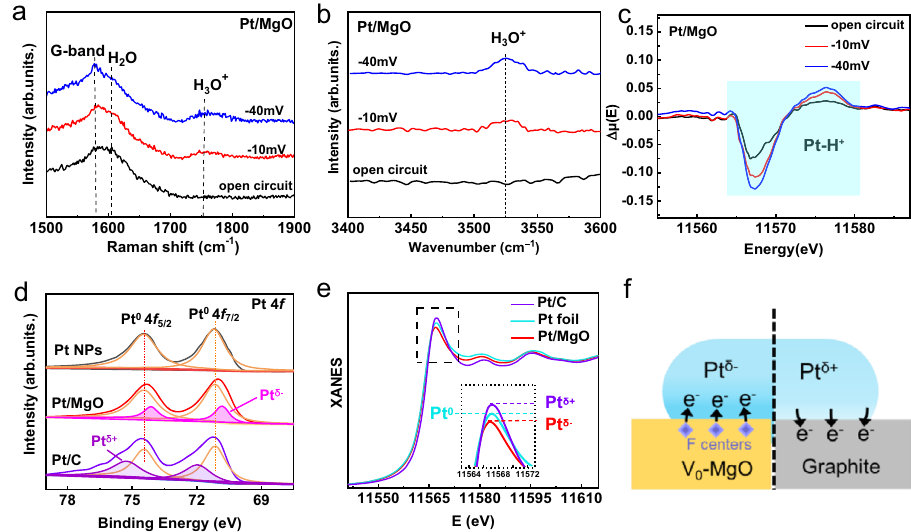
Fig. 2 Operando spectroscopy characterization and chemical states of Pt. The operando Raman spectra ( a ), SR-FTIR spectra ( b ), and XANES difference spectra ( c ) of Pt/MgO in 1 M KOH. d Pt 4 f XPS spectra and e Pt L 3 -edge XANES spectra of Pt/MgO, Pt foil and Pt/C. f Graphical representations of the electron transfer between Pt nanoparticles and the support (V O − MgO and